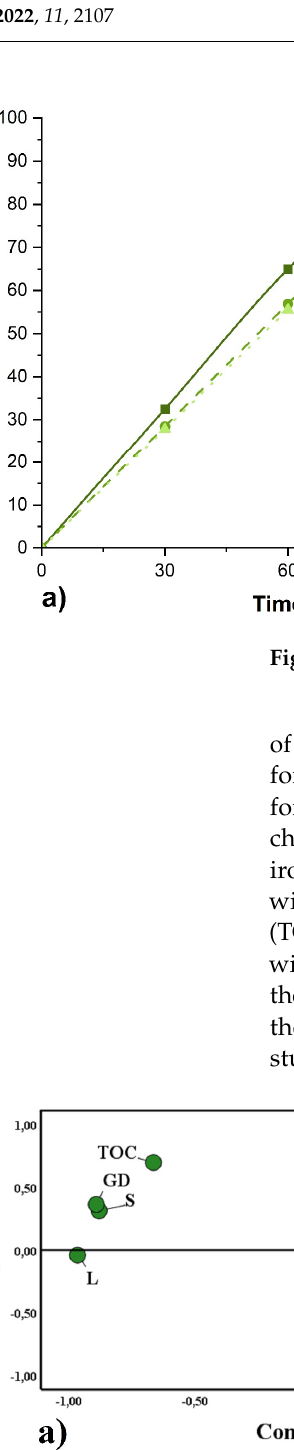
Figure 10. Principal component analysis, properties studied ( a ), and treatments ( b ).